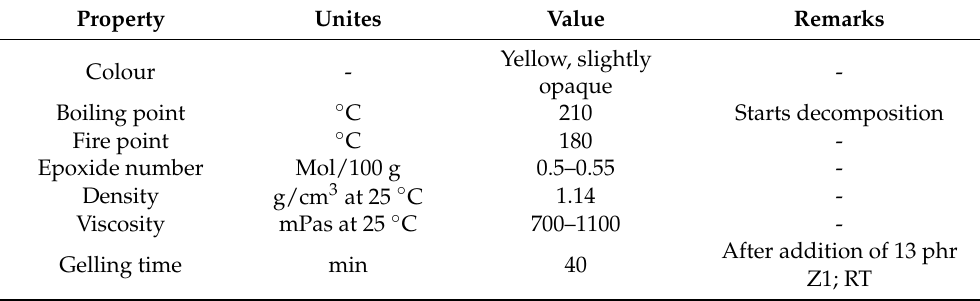
Table 2. Basic properties of Epidian 601 resin (low viscosity liquid) [29].